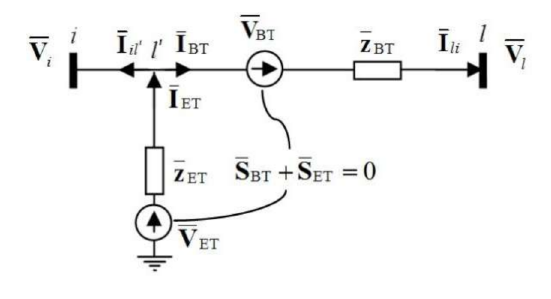
Figure 3. The assumed model for the quadrature